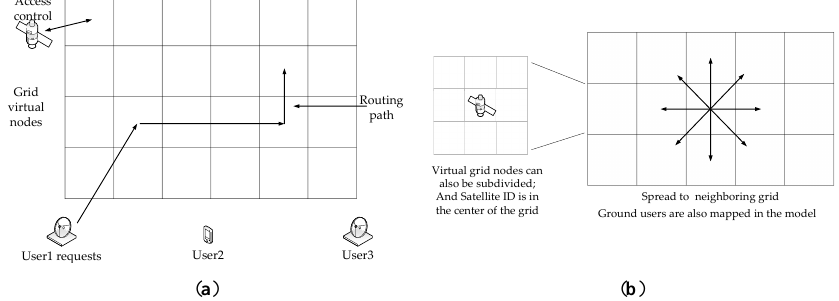
Figure 7. Grid network topology model: ( a ) virtual nodes (using the grid as a virtual node to connect the network in this area); ( b ) multi-scale virtual nodes and neighboring grids.